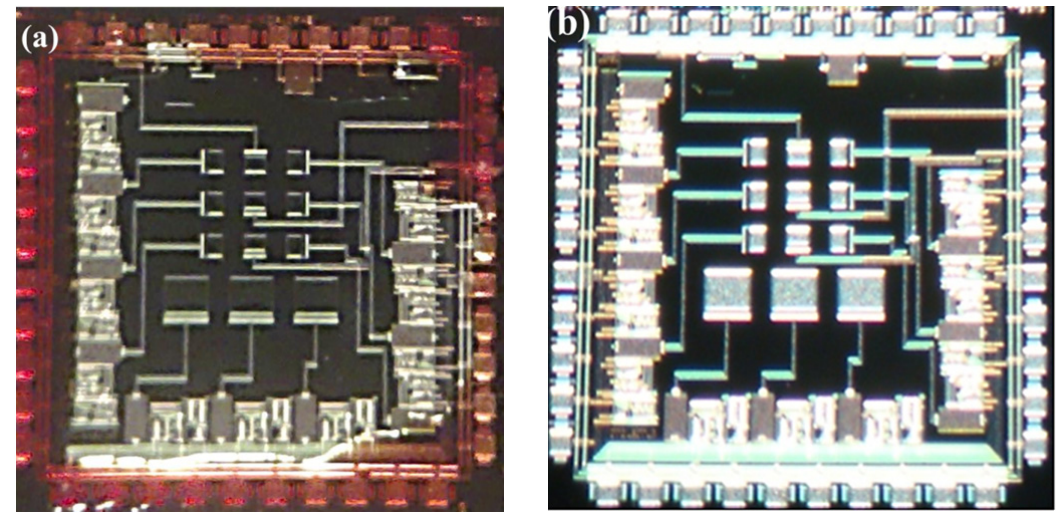
Figure 8 . Microphotograph of a single die (a) before and (b) after CMOS